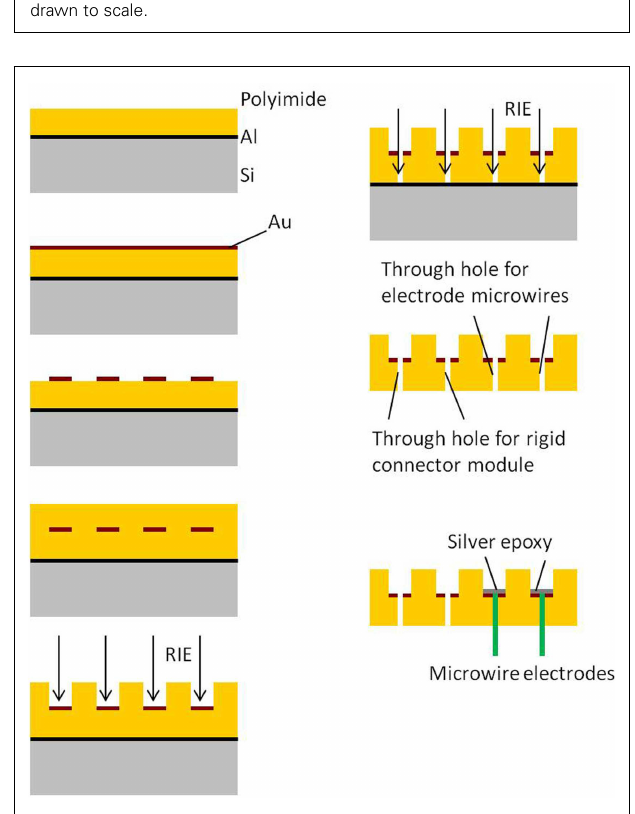
FIGURE 2 | Process flow for 2D transverse flexible cable module